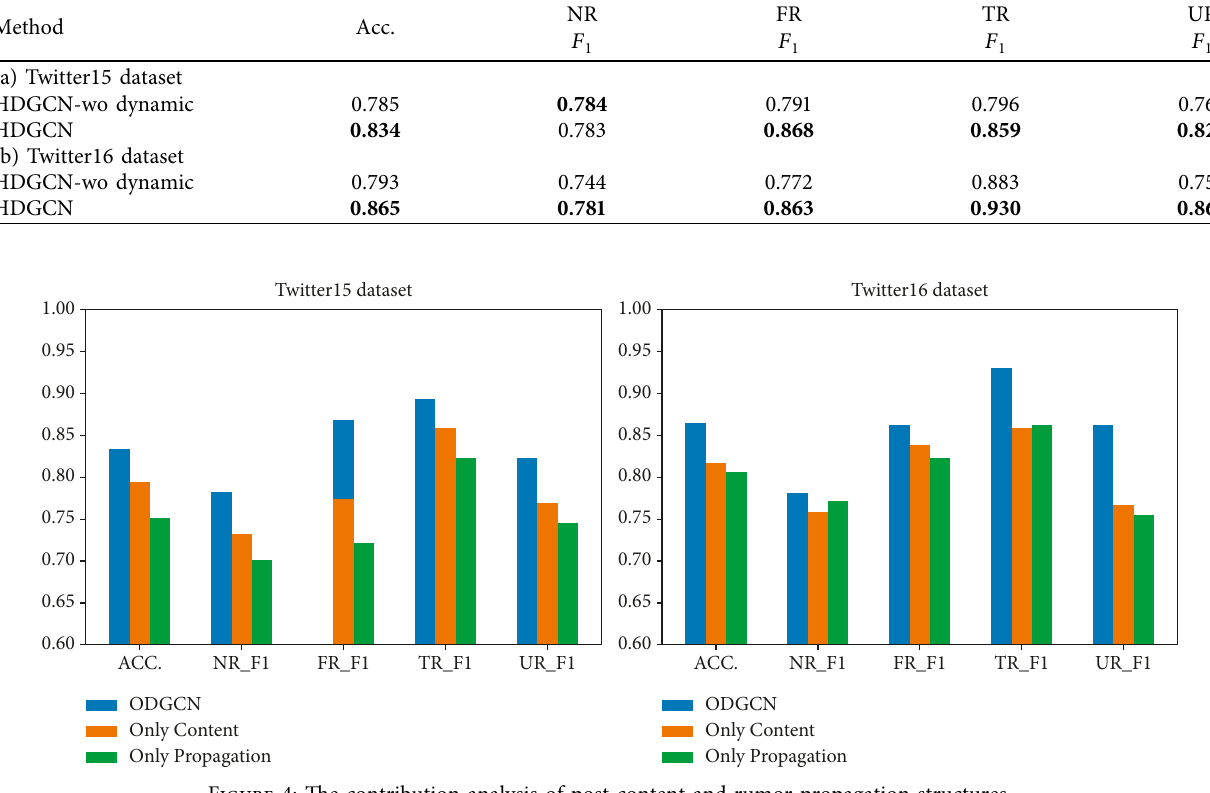
Figure 4: The contribution analysis of post content and rumor propagation